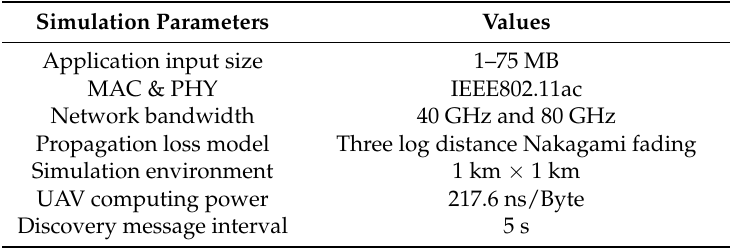
Table 1. Parameters and values setup for simulation